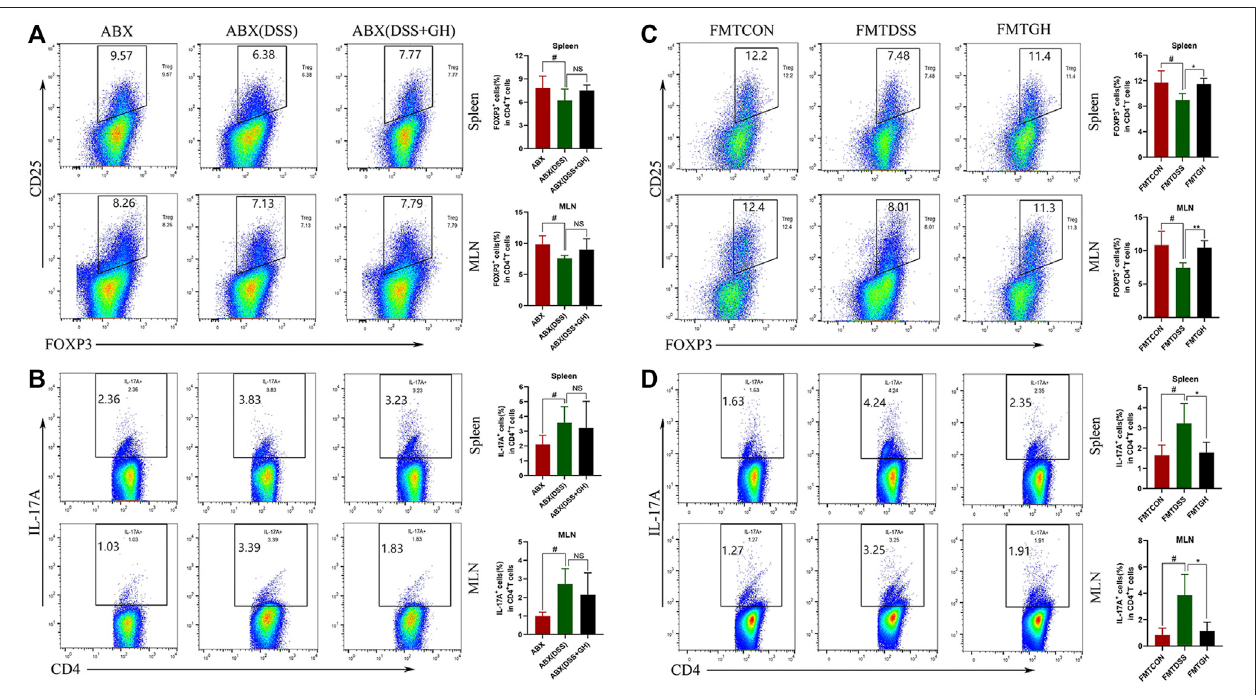
FIGURE 12 | The frequency of Treg cells and Th17 cells in mice splenocytes and MLNs after gut microbiota depletion and FMT. (A) Treg cells in the spleen and MLNs from ABX treatment groups were detected by fl ow cytometry and bar charts of the percentage of Treg cells were presented. (B) Representative plot and quantitativeanalysisofTh17cellsinthesplenocytesandMLNsofmicefromABXtreatmentgroups.Datawereexpressedasmean ± SD(n (cid:2) 3-5forMLNssamplesandn (cid:2) 5 – 10 for spleen samples). # p < 0.05, vs ABX group. (C) Representative plot and graph analysis of Treg cells in mice splenocytes and MLNs from FMT groups weredisplayed. (D) TheratioofTh17cellsproduced inmurinesplenocytesandMLNsweredetermined by fl owcytometryandbarchartsofthepercentage ofTh17cells were presented. Data were expressed as mean ± SD (n (cid:2) 3 – 5). # p < 0.05, vs FMTCON group; * p < 0.05, vs FMTDSS group. NS means no statistical signi fi cance.